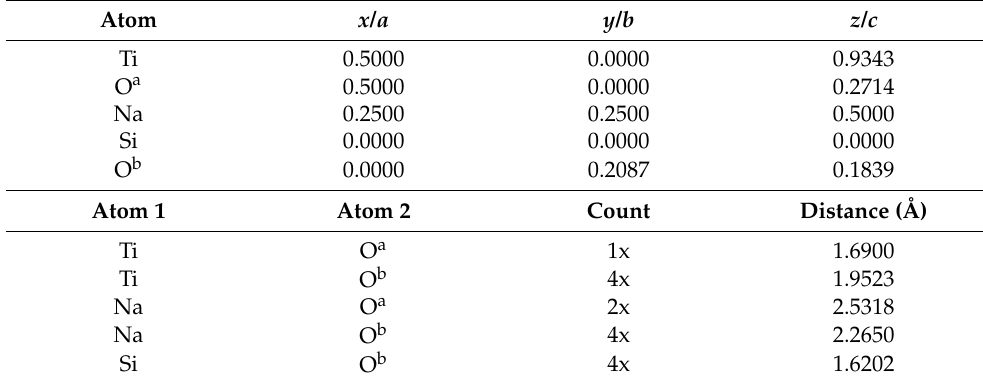
Table 2. Atomic site and bond distance of natisite after geometry